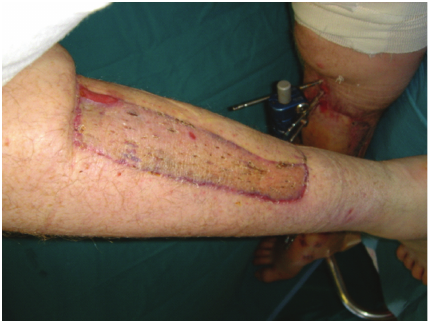
Figure 1: Cross-leg flap was harvested and partially sutured to the other leg to cover bone exposure.